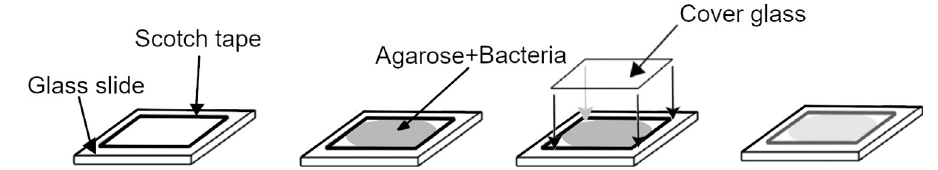
Fig 2. Thin-layer cultures. Step-by-step production of suitable thin-layer cultures with agarose pads and BHI medium.